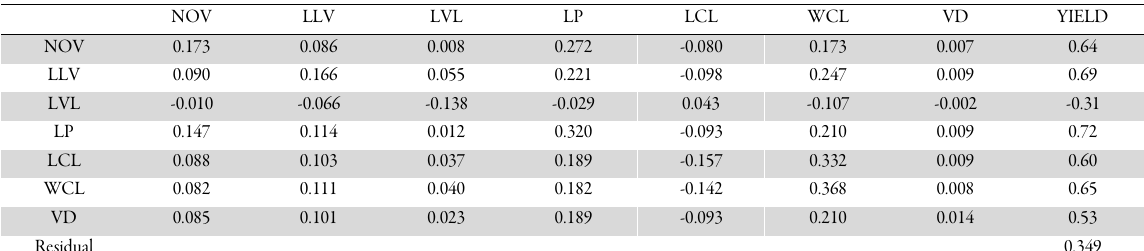
Table 2. Direct (Diagonal) and indirect effect of some yield component traits on leaf yield of T. occidentalis